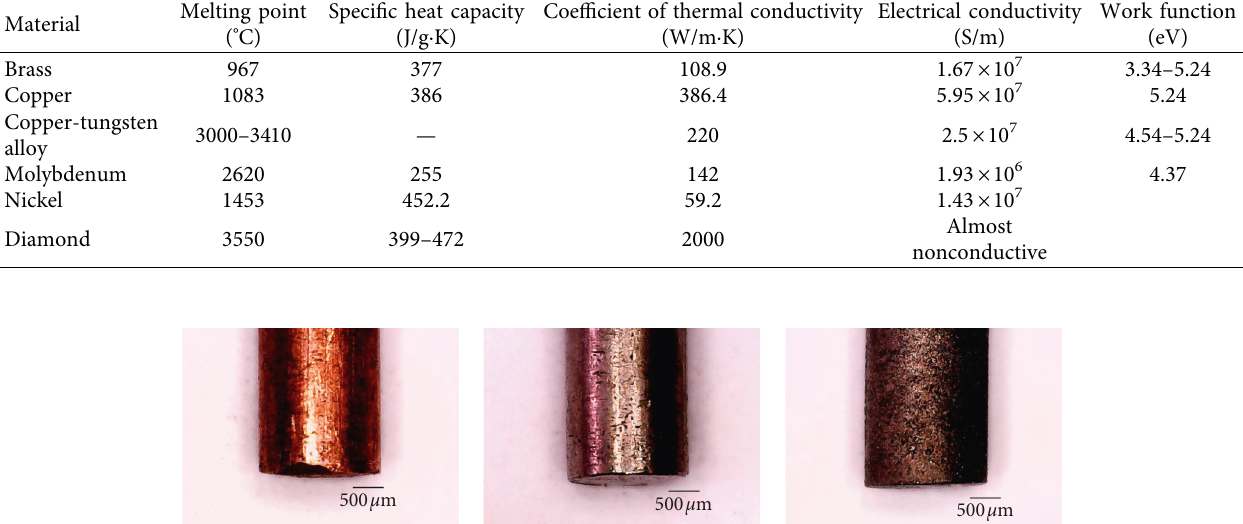
Table 6: Physical properties of materials.